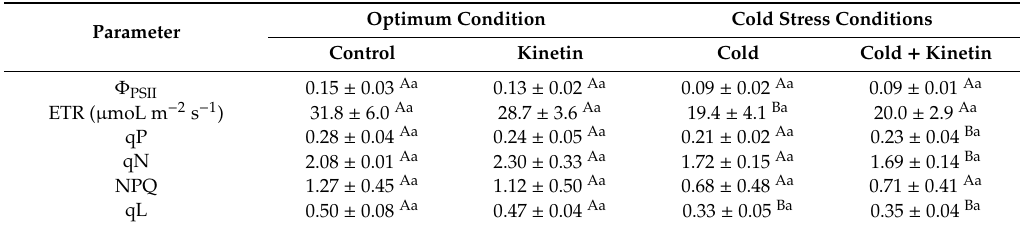
Table 2. E ff ect of exogenous kinetin on the PSII operating e ffi ciency ( Φ PSII), electron transfer rate (ETR), photochemical quenching (qP), non-photochemical quenching (NPQ), fluorescence quenching (qN), and the fraction of open PSII centers (qL) in the leaves of co ff ee seedlings under optimum and cold stress conditions, 25 / 20 ◦ C and 12 / 12 ◦ C, respectively.